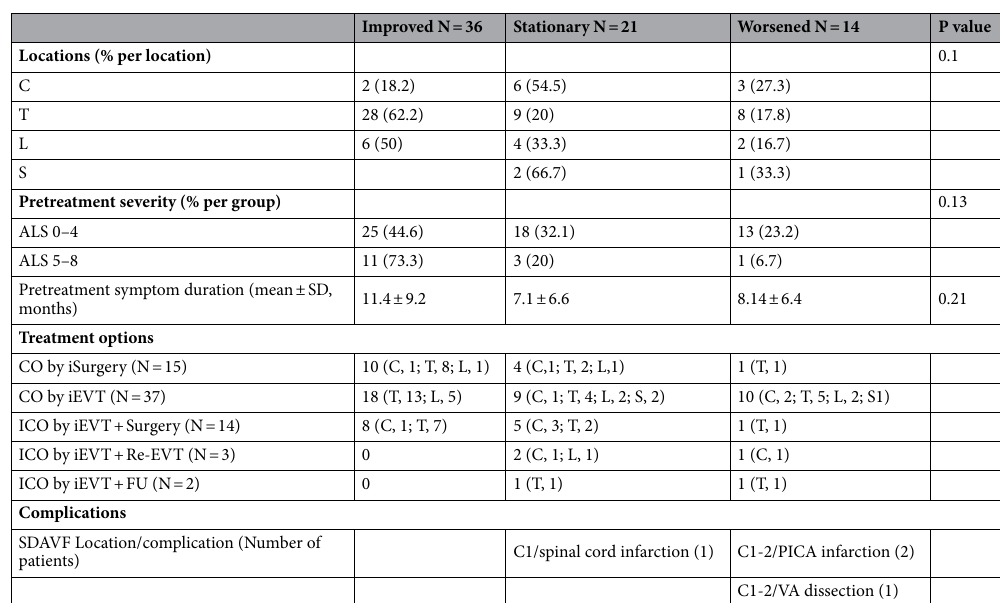
Table 4. Functional outcomes of 71 patients with spinal dural arteriovenous fistula at last follow-up. Values represent numbers of patients (%). ALS Aminoff-Logue scale; CO complete occlusion; iEVT initial EVT; iSurgery initial Surgery; ICO incomplete occlusion; Re-EVT repeated EVT; FU